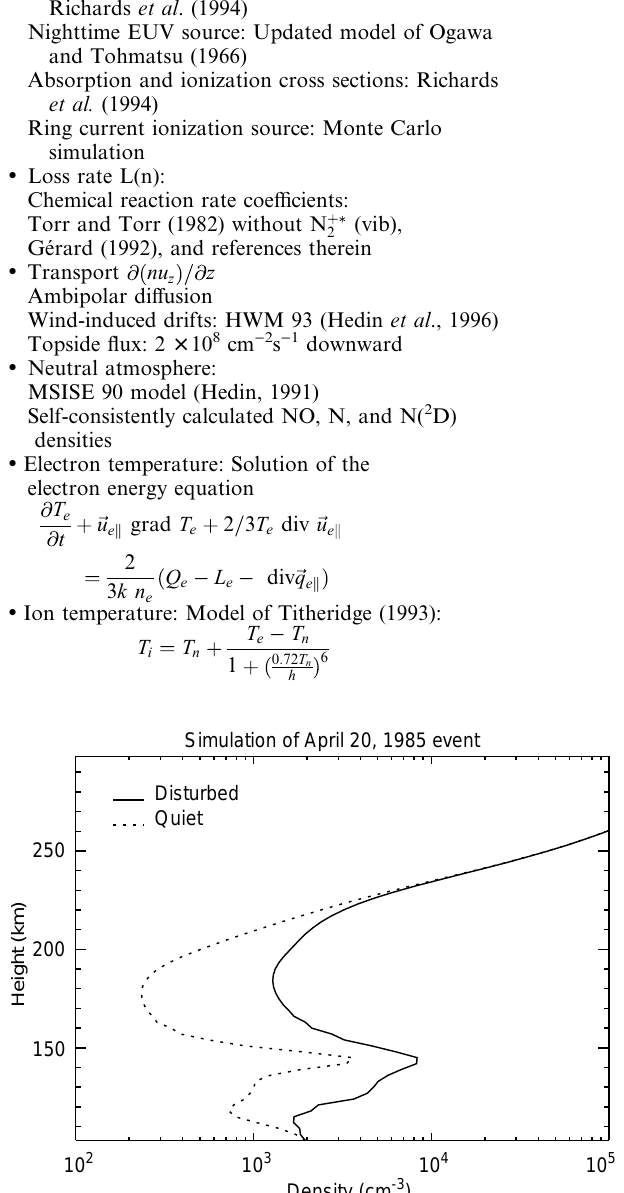
Fig. 6. Electron density profiles calculated for a location near Arecibo at 30 (cid:176) magnetic latitude with (disturbed) and without (quiet) the ring current ionization source. The model ring current decay was assumed to begin at 22:00 LT, and the electron density profiles were obtained 1 1/2 hours later at 23:30 LT. The general conditions apply to the day of the ring current measurements, i.e. April 20, 1985